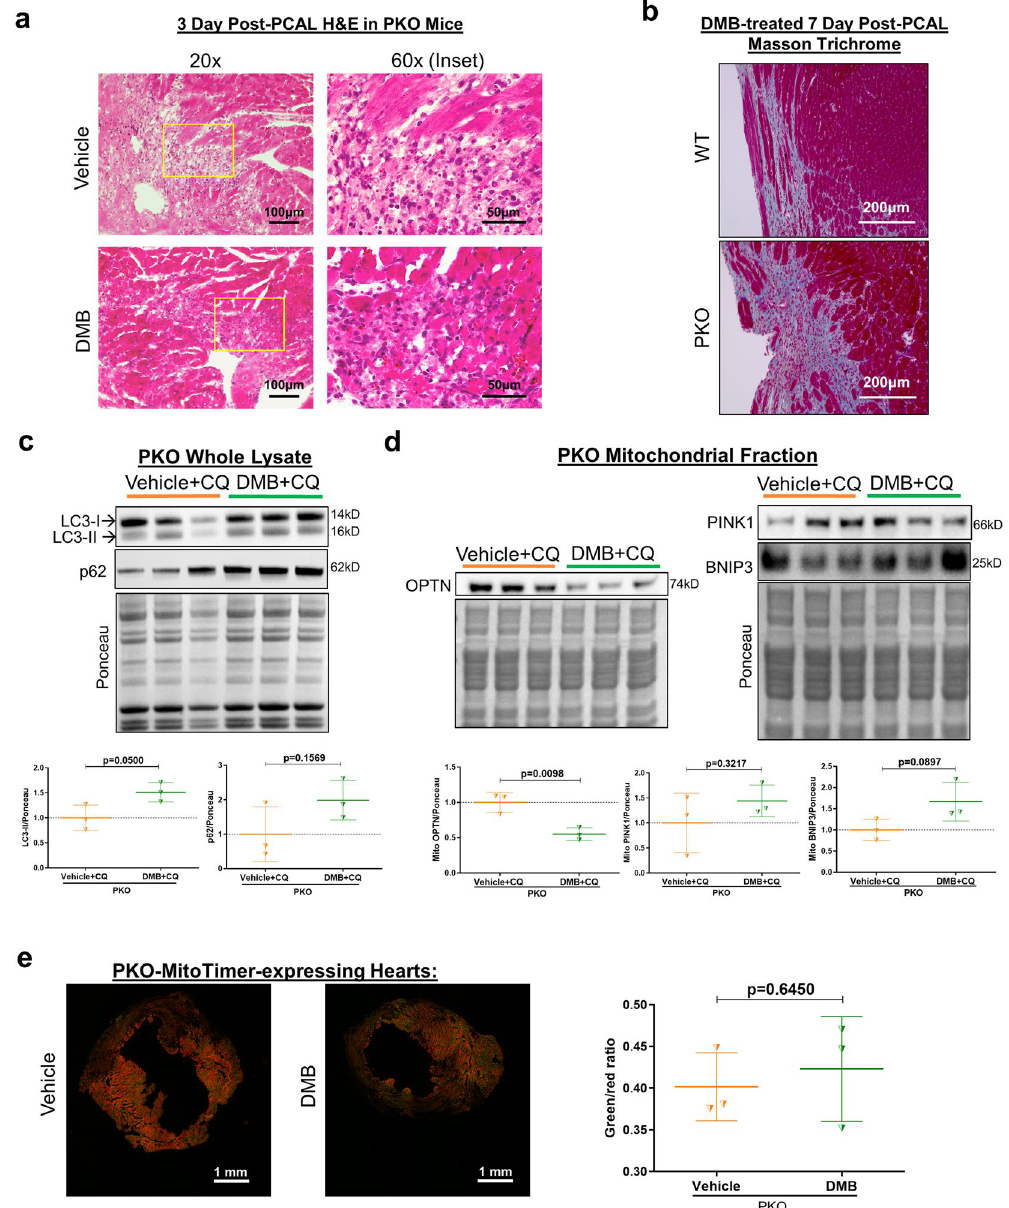
Figure 4. DMB fails to limit inflammation, fibrosis and induce mitochondrial turnover in PKO mice. Age- matched PKO mice underwent permanent coronary artery ligation and were given vehicle (50 µ L DMSO) or DMB (10 pmoles/25 g) i.p. 2 hours after surgery and again 2 and 5 days later. Mice were sacrificed 3 days after PCAL (n = 3–4 mice/group) for H&E staining and MitoTimer ratiometric shifts, and 7 days after PCAL for Masson Trichrome staining. A second cohort of mice received vehicle (50 µ L DMSO) or DMB (10 pmoles/25 g) i.p. One hour later, mice received chloroquine (CQ, 10 mg/kg i.p.) and were sacrificed 16 hours later (n = 3/ group) for western blot analysis of autophagy and mitophagy markers. (a) Representative 60X and 20X magnification of heart sections stained with H&E showing immune cell infiltration in PKO mice 3 days post-MI; (b) Representative 20X magnification of heart sections with Masson Trichrome 7 days after PCAL showing fibrosis in PKO vs . wild type in DMB-treated mice. (c) Western blot analysis and quantification of autophagy markers p62 and LC3 in heart whole lysates of PKO mice; (d) Western blot analysis and quantification of mitophagy markers PINK1, Optineurin (OPTN) and BNIP3 in the mitochondrial-enriched fraction of PKO mice; (e) Cryopreserved sections of the heart were examined for MitoTimer ratiometric shifts (green/red ratio = new/old mitochondria) as an indication of mitochondrial biogenesis (n = 4 mice/group). All values are presented as mean ± standard deviation. Scale bars as indicated. Standard Student’s t -test was used to compare the groups. WB figures were cropped and all densitometry was performed using NIH Image J software v 1.51 (https://imagej.nih.gov/ij/download.html). Full-length blots/gels are presented in Supplementary Figure